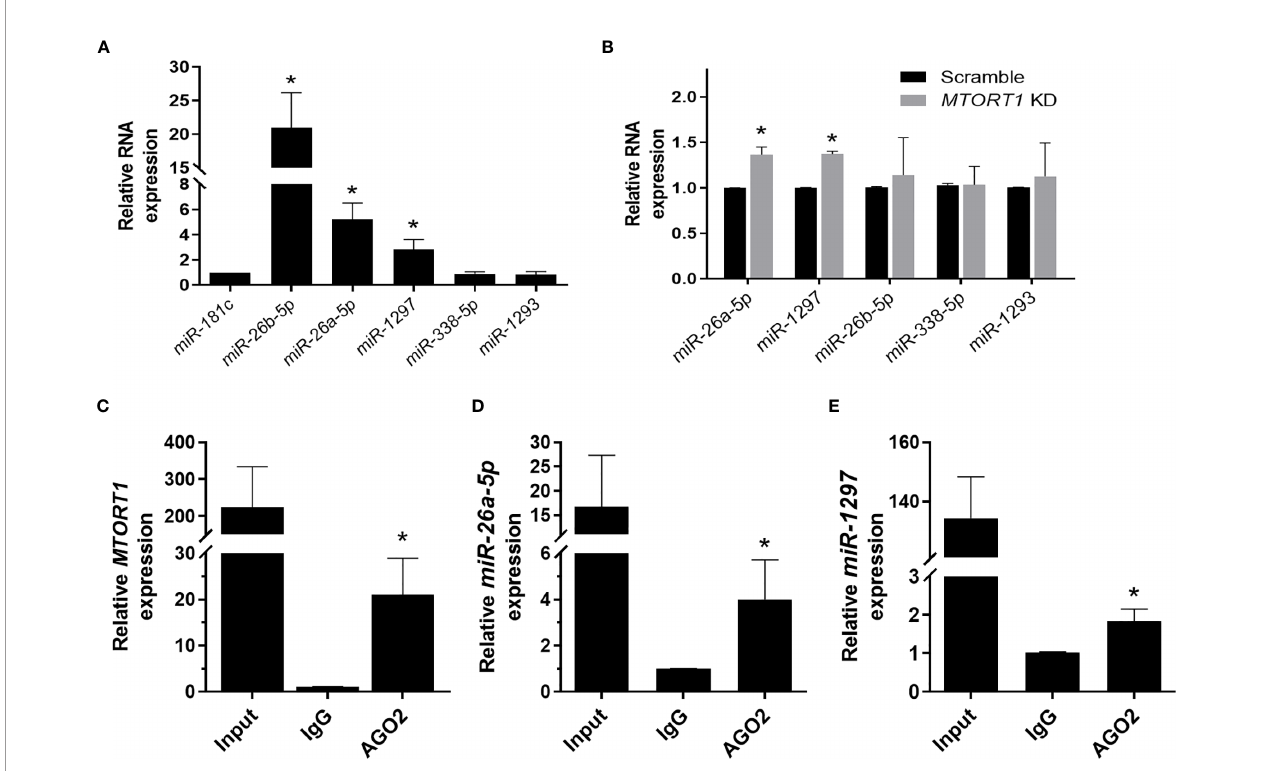
FIGURE 5 | MTORT1 serves as a miRNA sponge. (A) Enrichment of miRNA candidates in mitochondria in MCF-7 cells. Candidates of miRNA were predicted using miRDB (26). Relative expression levels of miRNA were measured by quantitative RT-PCR and compared to that of miR-181c , which was reported as a mitochondrial miRNA. (B) Relative expression levels of miRNA candidates in MTORT1 knockdown cells were measured by quantitative RT-PCR and normalized to 18S rRNA. (C – E) RNA immunoprecipitation analysis of MTORT1 (C) , miR-26a-5p (D) , and miR-1297 (E) using antibody against AGO2 in MCF-7 cells. Relative expression levels of AGO2-enriched non-coding RNA were measured by quantitative RT-PCR and compared to those pulled down by IgG. The results are means ± SDs (n = 3). * P <